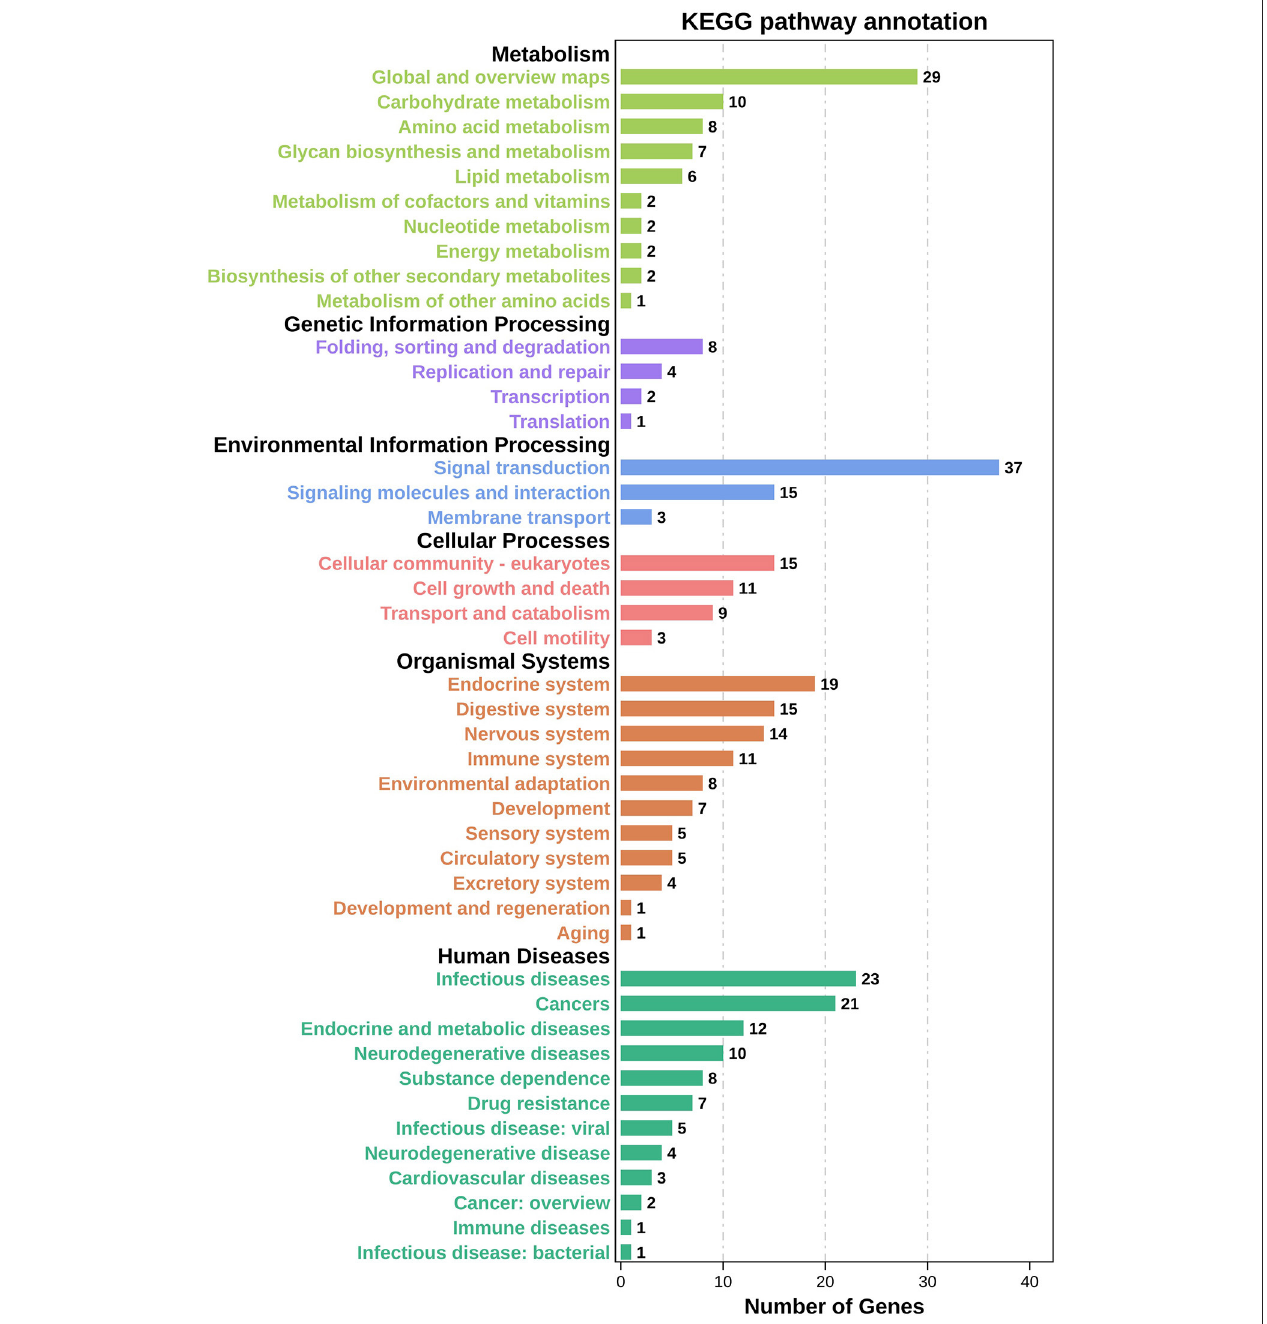
FIGURE 5 | The summary of Kyoto Encyclopedia of Genes and Genomes (KEGG) pathway enrichment analysis performed for biological process, cellular component, and molecular function. Functional annotation of candidate selective genes that comprised significant SNPs ( p < 1.00E − 5).